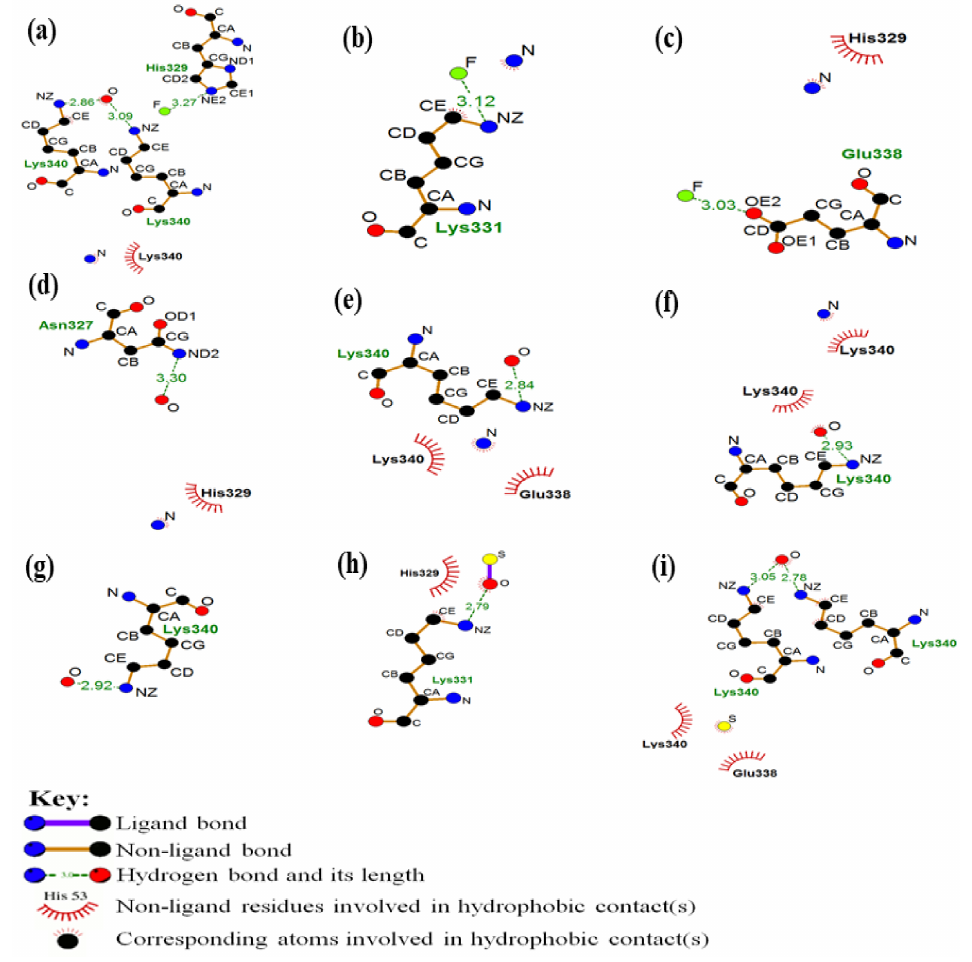
Figure 3. Representation of the 2D-Lig-Plot diagram of interactions of each diagnostic systems formed by the fullerol plus the fluorescent radiopharmaceuticals ligands interacting with the most critical target residues of the (PHF)-tau protein as: ( a ) (PHF)-tau protein plus fullerol/ 18 F-FDDNP, ( b ) (PHF)-tau protein plus fullerol/ 18 F-T807, ( c ) (PHF)-tau protein plus fullerol/ 18 F-T808, ( d ) (PHF)-tau protein plus fullerol/ 18 F-THK523, ( e ) (PHF)-tau protein plus fullerol/ 18 F-THK5105, ( f ) (PHF)-tau protein plus fullerol/ 18 F-THK5117, ( g ) (PHF)-tau protein plus fullerol/ 18 F-THK5351, ( h ) (PHF)-tau protein plus fullerol/ 11 C- N -methyl Lansoprazole, and ( i ) (PHF)-tau protein plus fullerol/ 11